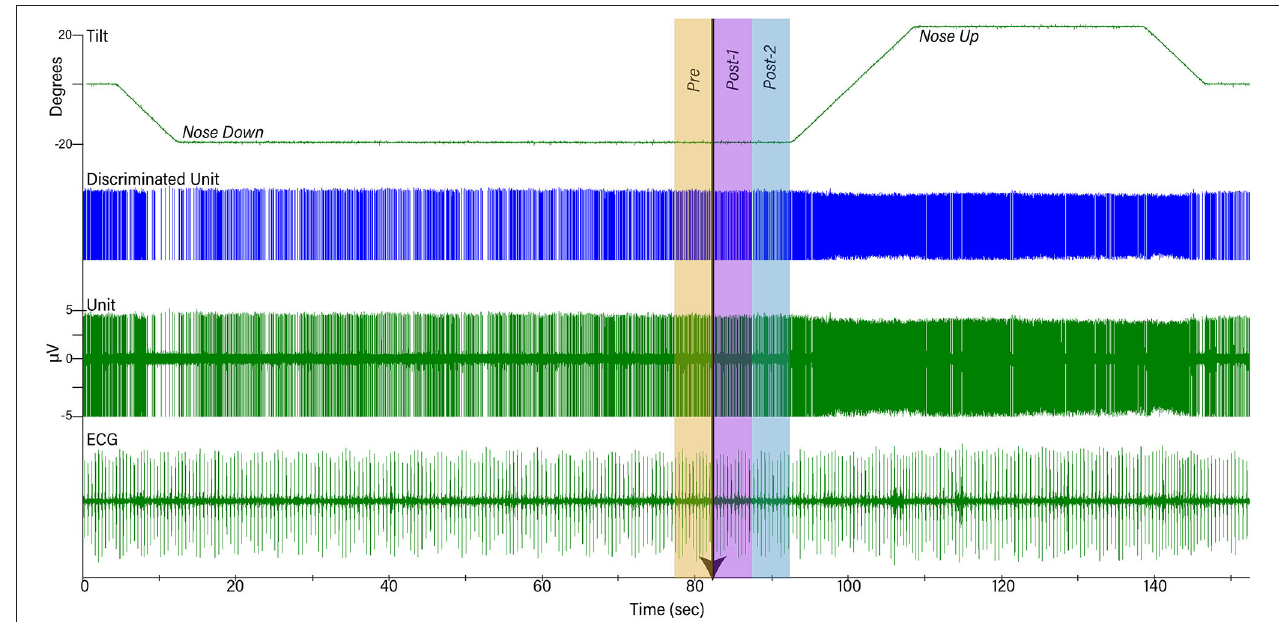
FIGURE 1 | Example of data collected during one trial. The top trace shows table position, the second shows discriminated activity for one unit, the third shows raw unit activity recorded by a microelectrode, and the bottom trace is a recording of the electrocardiogram (ECG). Initially, animals were positioned 20 ◦ nose-down for a variable amount of time. A light cue was presented (onset indicated by arrow) that lasted for 2s. Ten seconds after the light cue was initiated, animals were tilted 40 ◦ head-up (20 ◦ nose-down to 20 ◦ nose-up) and remained in that position for 30s prior to returning to the prone position. To determine if the light cue had any effect on a unit’s activity, firing rate during the period 5s before light onset (Pre-) was compared to that during the period 5–10s prior to tilt onset (Post-2).